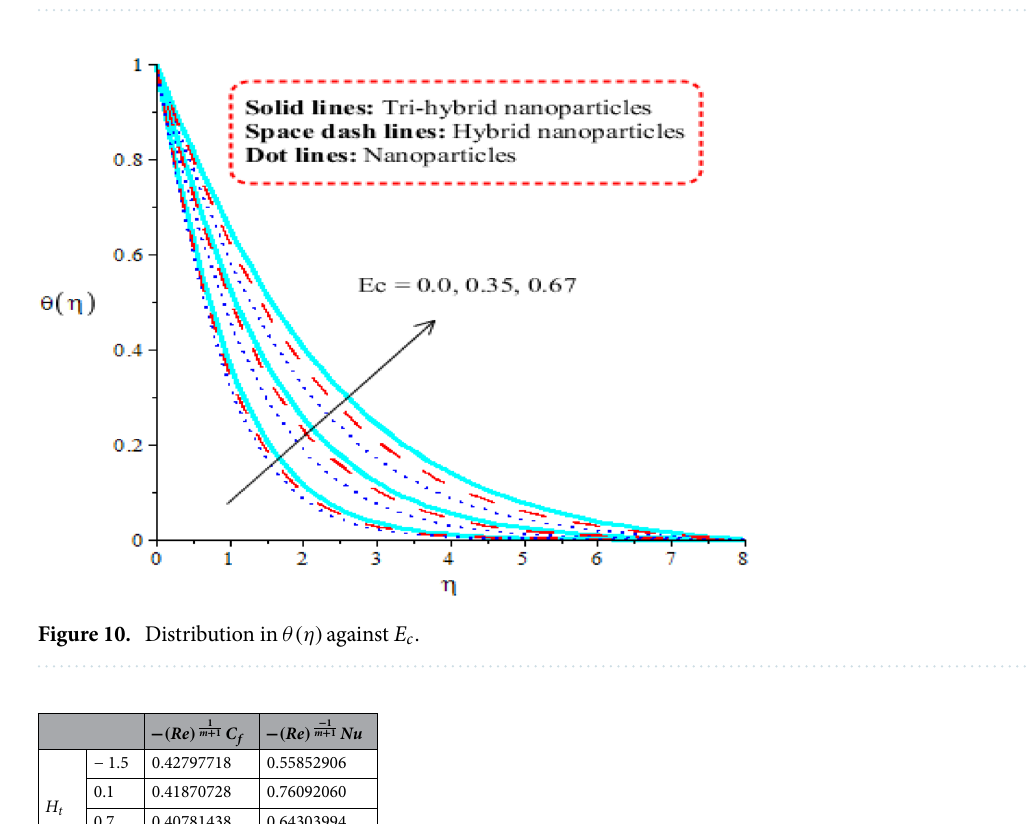
Figure 9. Distribution in θ(η) against F r .